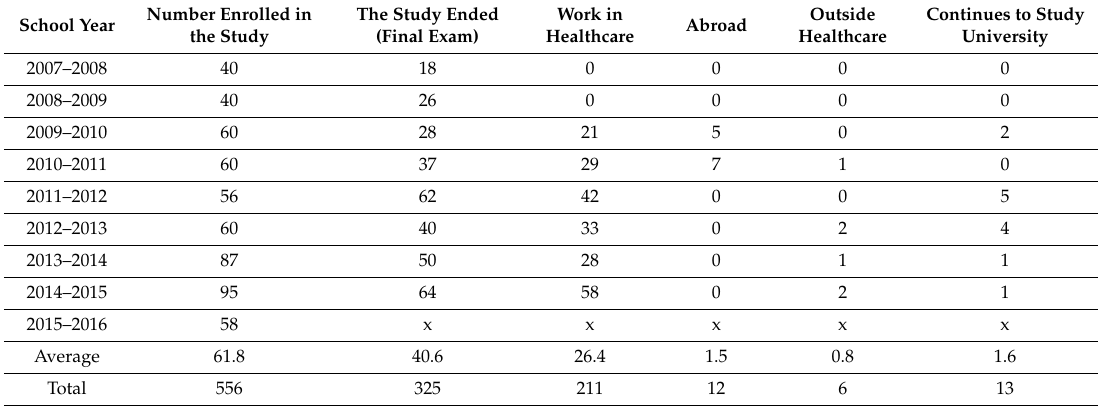
Table 6. Qualified general nurse and midwives from the Secondary Medical School Hradec Kralove and